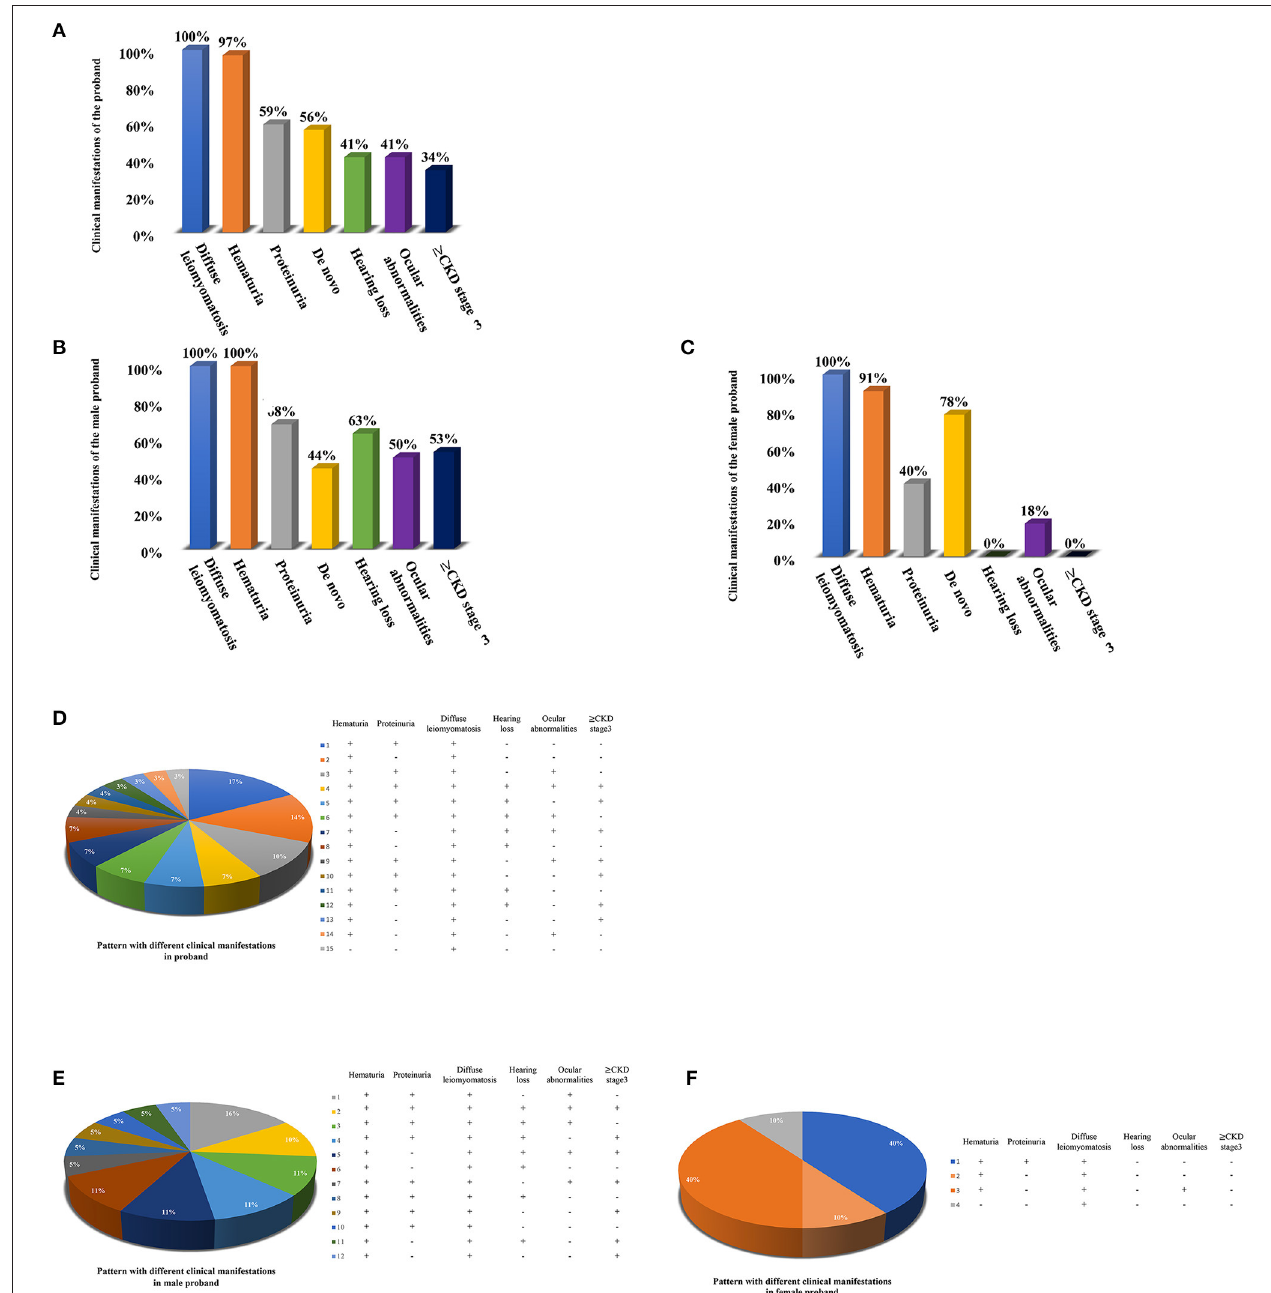
FIGURE 6 | Clinical manifestations of the AS-DL proband and the pattern with different clinical manifestations. (A) Clinical manifestations of the total AS-DL proband. (B) Clinical manifestations of the male AS-DL proband. (C) Clinical manifestations of the female AS-DL proband. (D) The pattern with different clinical manifestations. (E) The pattern with different clinical manifestations in male probands. (F) The pattern with different clinical manifestations in female probands.